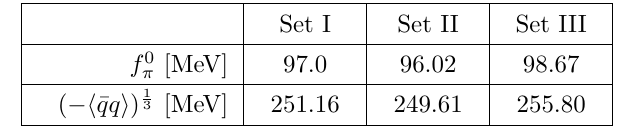
Table 1 . Weak decay constant in the chiral limit (4.10) and quark condensate (4.11) calculated with the solutions for M ( p 2 ) and Z ( p 2 ) using the longitudinal (2.20) and transverse (2.21) vertex in the DSE (2.15) and the three sets of gluon and ghost propagators introduced in section 3. procedure as in eqs. (4.3) and (4.4). Then, we apply this contour solution in Cauchy’s integral formula again to find solutions for σ